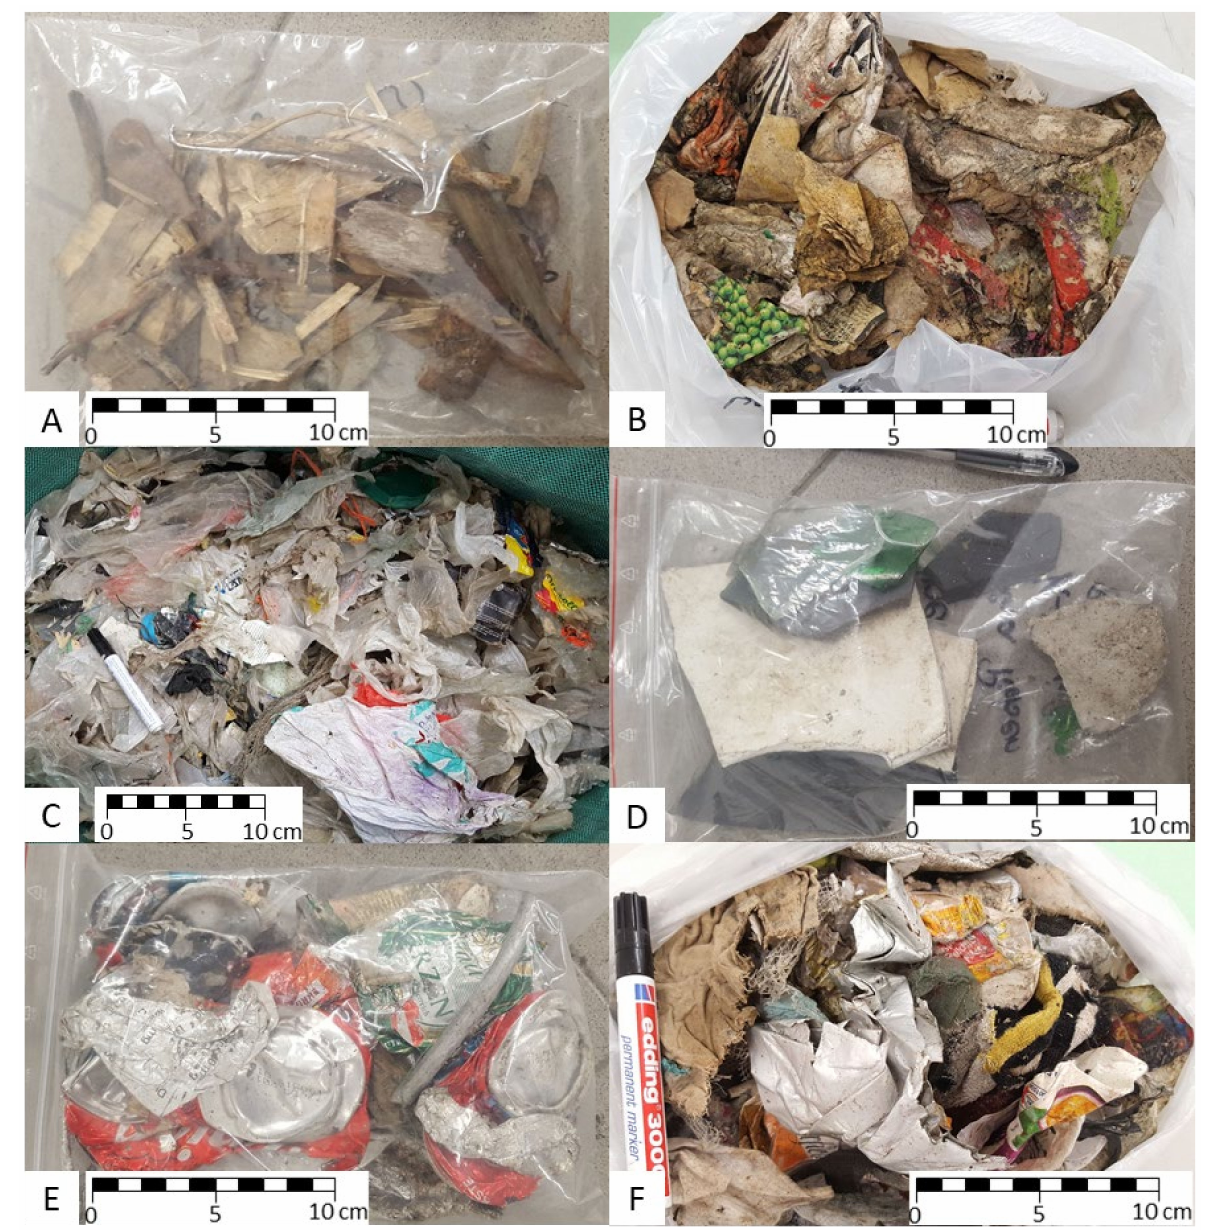
Figure A3. Exemplary photos of the manually sorted material fractions: wood— A ; P&C— B ; plastics— C ; inert— D ; metals— E ; others— F